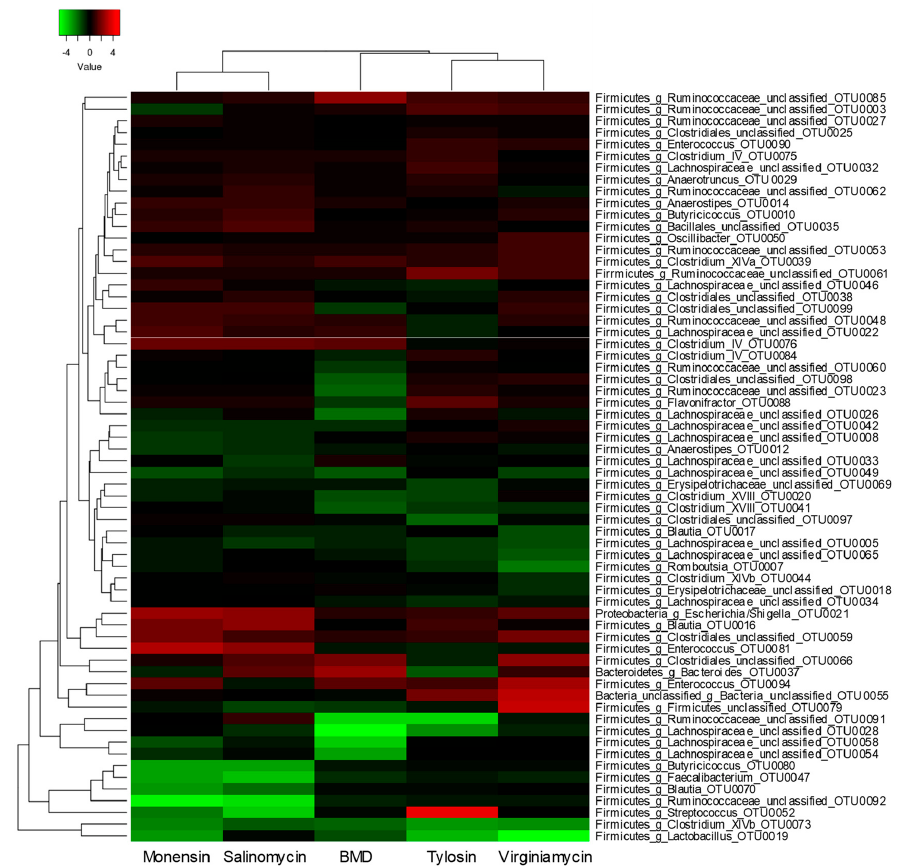
Figure 5. Differential regulation of the top 100 OTUs by in-feed antimicrobials. Among the top 100 OTUs, 64 were significantly affected by at least one antimicrobial and thus plotted using Heatmapper [25]. Fold change was calculated as the mean relative abundance of an OTU in an antimicrobial group relative to that in the control, followed by log 2 transformation for visualization. Both rows and columns were clustered using the Euclidean distance and average linkage.